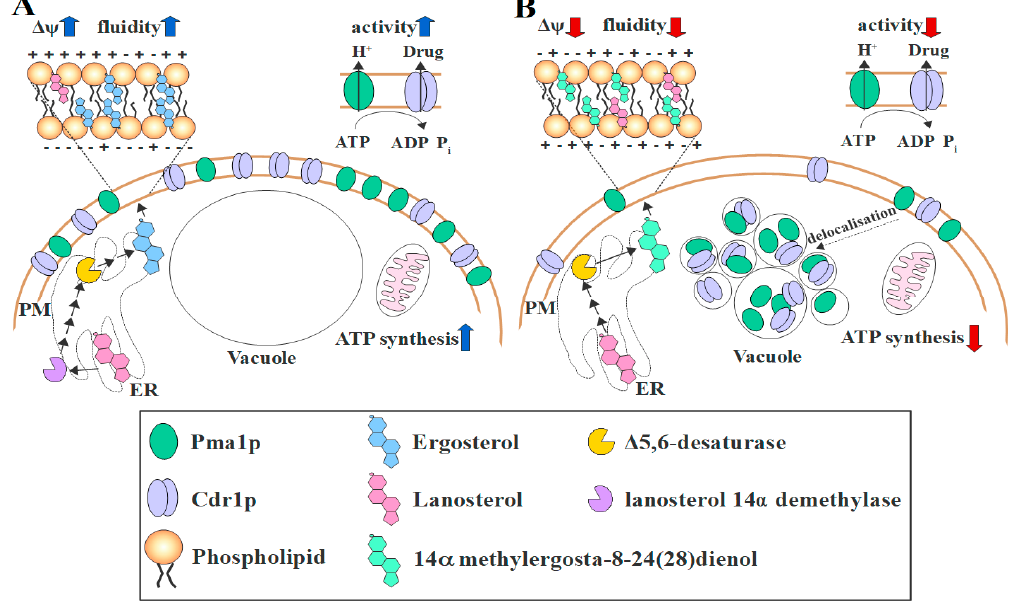
Figure 5. A general model of the influence of ergosterol on Cdr1p and Pma1p (H + -ATPase) localization; plasma membrane (PM) fluidity, and ATP level; red and blue arrows stand for lower and higher, respectively. (A) In a C. albicans wild type (WT) strain ergosterol is synthesised in the endoplasmic reticulum (ER) from lanosterol by several enzymes, including lanosterol 14 α demethylase (Erg11p) and ∆ 5,6-desaturase (Erg3p). Ergosterol and lanosterol are incorporated into the PM and other membranes in the cell. Proper fluidity enables Pma1p and Cdr1p to localise into the PM, where the activity of both proteins depends on ATP, synthesised in the mitochondria. H + -ATPase modulates the potential of the PM ( Δψ ). ( B ) Deletion of the ERG11 gene results in non-specific modifications of lanosterol. The final step is catalysed by Erg3p and leads to the incorporation of 14 α methylergosta-8-24(28)dienol with lanosterol in the PM. Abnormal PM composition and rigidity disables Pma1p and Cdr1p from proper localization and these proteins delocalise into vacuoles, which are not fused in erg11 Δ / Δ . Delocalization and reduced ATP level lead to reduced activity of Cdr1p and Pma1p. The potential of PM is reduced due to low Pma1p activity.